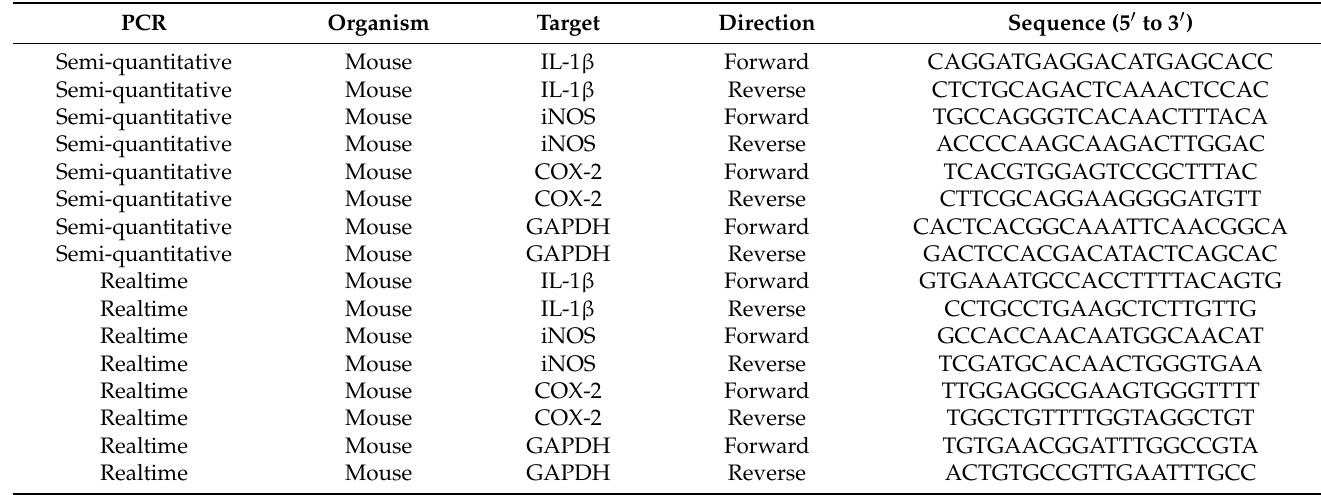
Table 1. PCR primer sequence